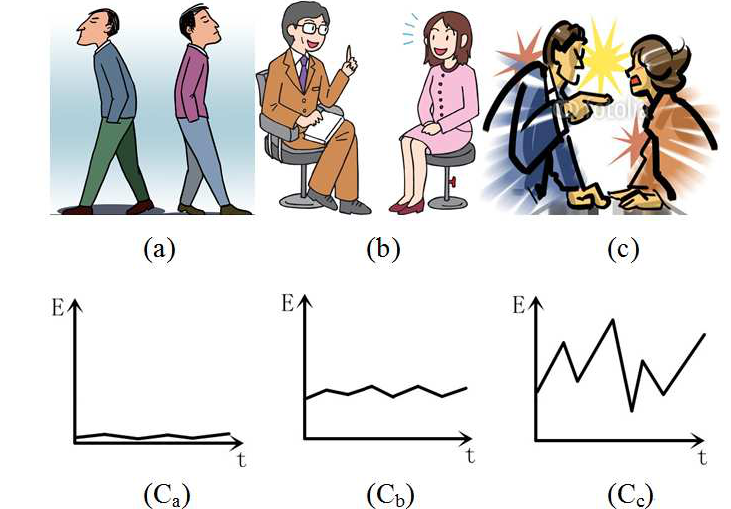
Figure 2. Different situations of people communicating and their probable sound feature curves, which include unconcerned behavior ( a ), normal talking ( b ), and quarreling ( c